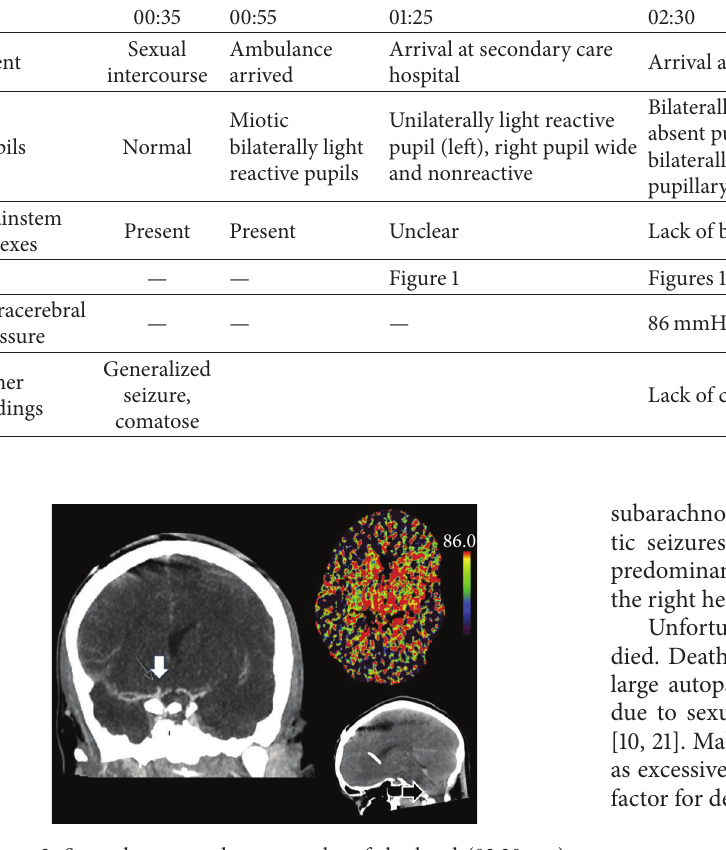
Figure 2: Second computed tomography of the head (02:30 am) shows an aneurysm at the right carotid T cross, pan-cerebral diminished perfusion, and developing tonsillar